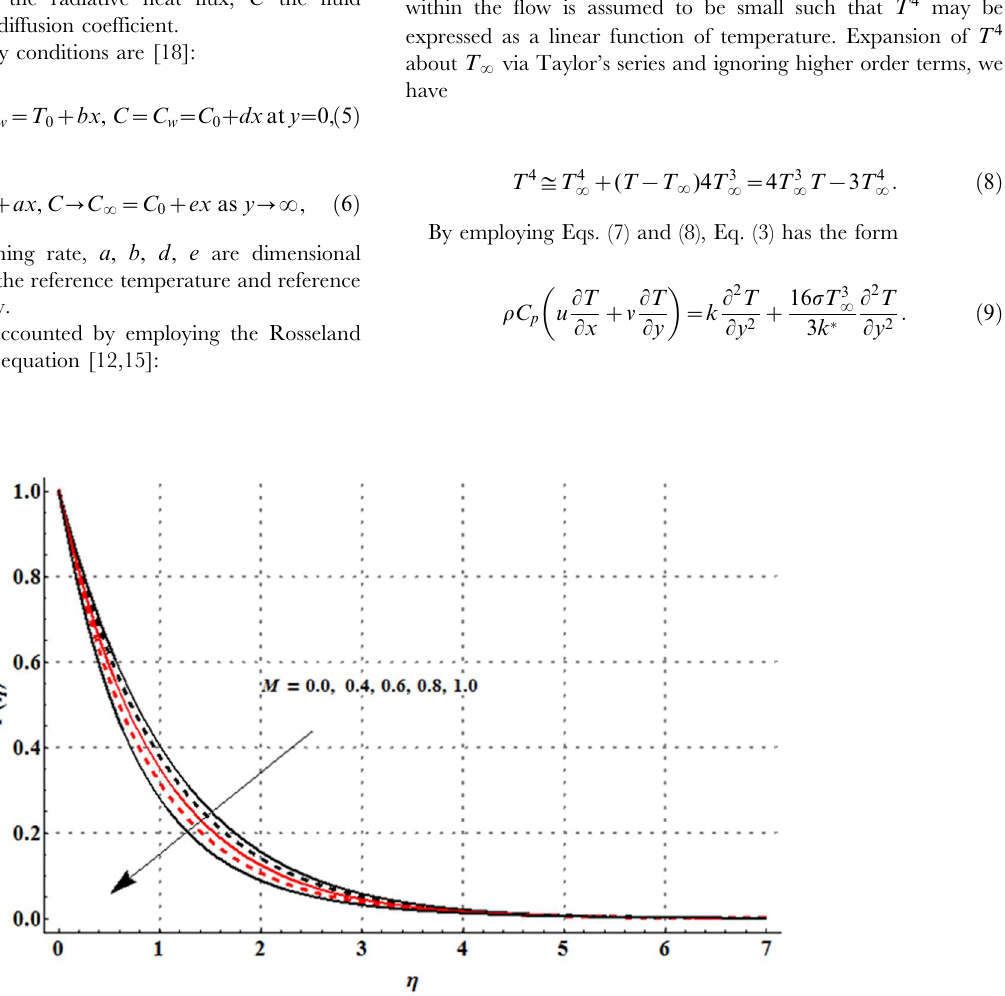
Figure 3. Influence of M on the velocity profile f ’ ( g ) when b ~ 0 : 4 ~ Rd , l 1 ~ 0 : 5, l ~ 0 : 3 ~ N , Pr ~ 1 : 2, S ~ 0 : 2 ~ S (cid:2) and Sc ~ 1 : 0 : doi:10.1371/journal.pone.0107858.g003 PLOS ONE |